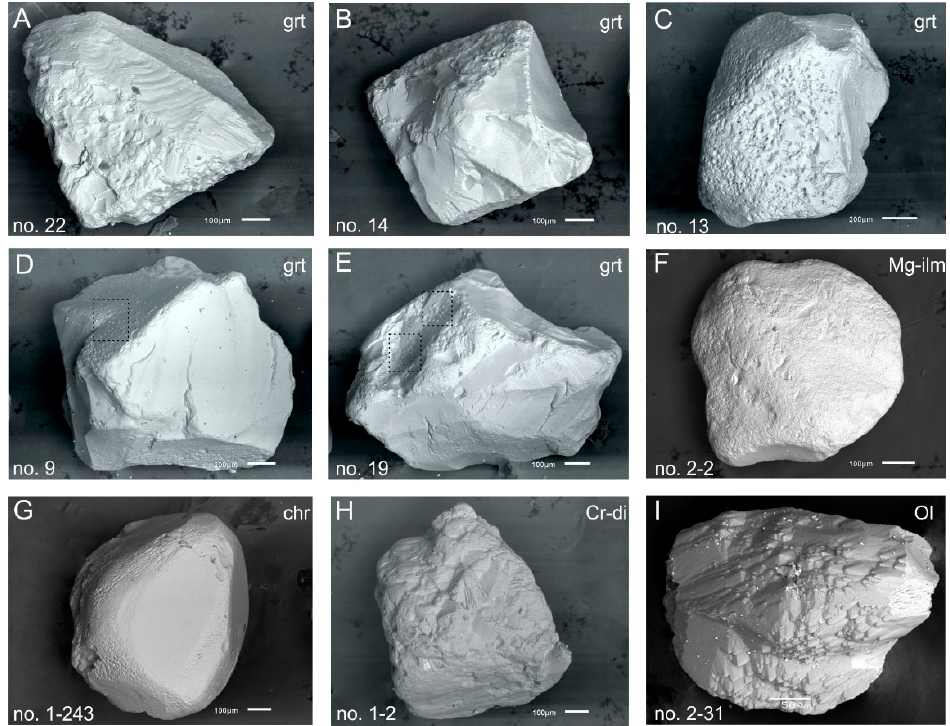
Figure 8. Back-scattered electron images of kimberlite indicator minerals (KIMs) from the KL-01 pipe. ( A – E ): garnet (grt), ( F ):Mg-ilmenite, ( G ): chromite (chr), ( H ): Cr-diopside (Cr-di), ( I ): olivine (ol). A, E and F—with relics of a pyramidal shingle-like relief; B—with signs of melting; C–E with signs of chemical corrosion, C—with etching channels, D and E—with “drop-like” relief; F—with rough